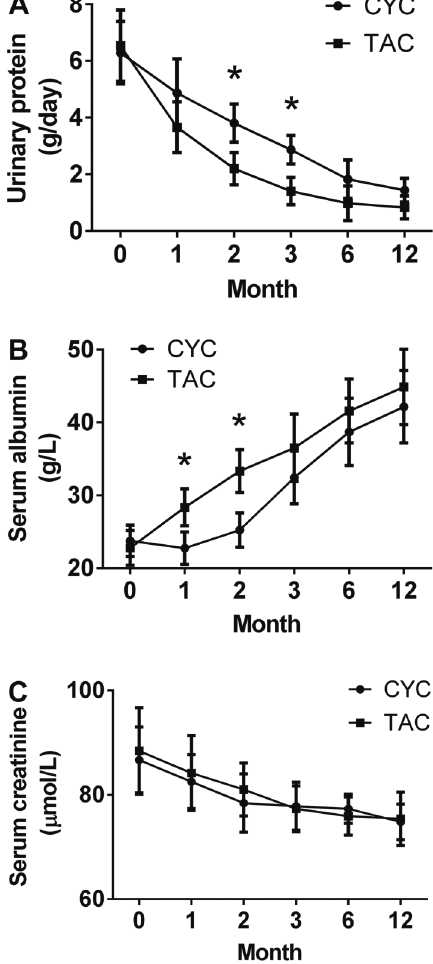
Figure 1. Evolution of the secondary end points in two groups. Daily urinary protein ( A ), serum albumin ( B ), serum creatinine ( C ). CYC: cyclophosphamide; TAC: tacrolimus. *P o 0.05, TAC group vs CYC group ( t